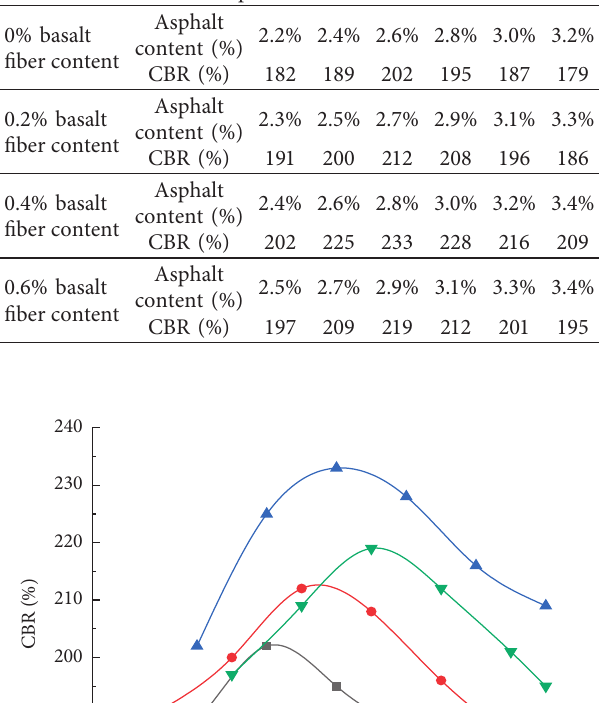
Figure 4: Void percentage. Table 6: CBR values of specimens with different fiber contents.